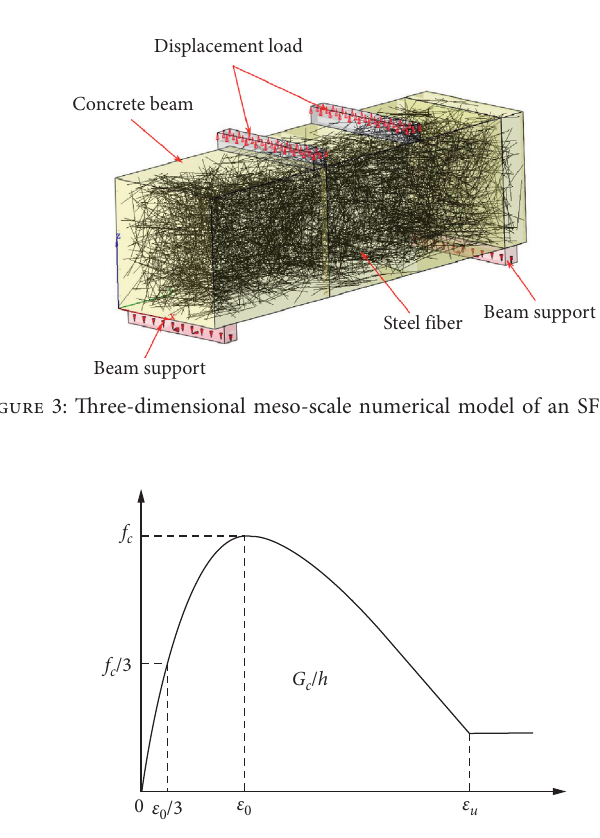
Figure 4: Compression constitutive relations of the parabolic model. co and maximum aggregate size